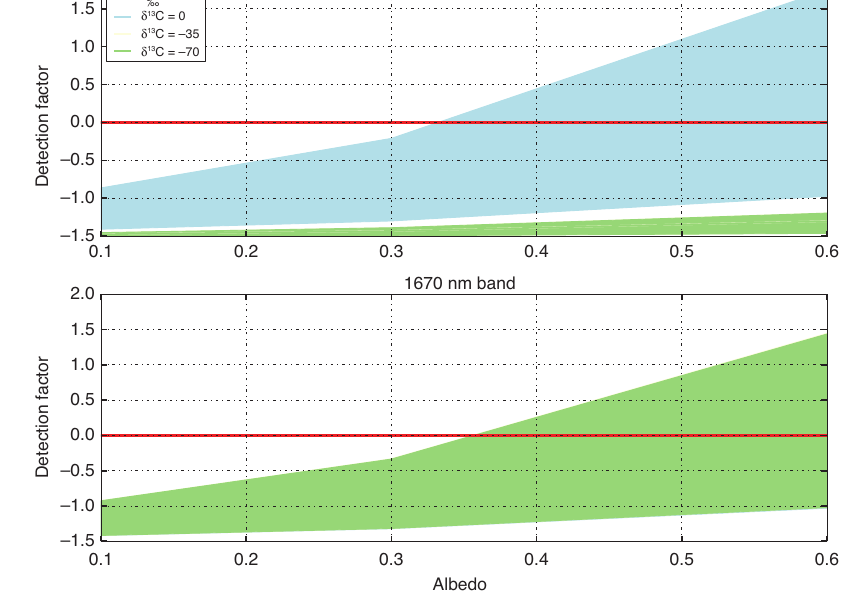
Figure 10 Plot indicating the surface conditions required to generate detection factors >0, thus suggesting a positive detection of δ 13 C. The top panel shows results for the 1658 nm band, and the bottom panel shows results for the 1670 nm band. The light blue area indicates results assuming a δ 13 C natural value of 0‰, light yellow −35‰ and light green −70‰, the solid red line indicates where the detection factor is